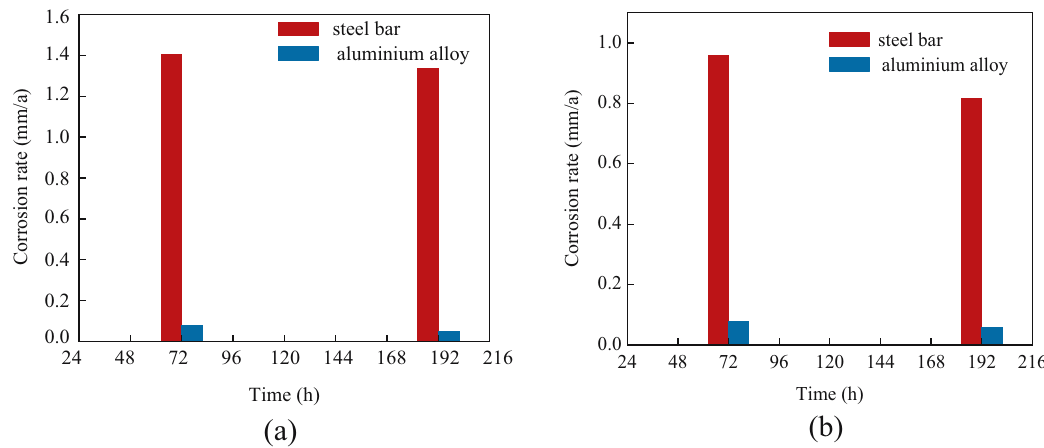
Figure 7: Comparison of corrosion rate between aluminum alloy and steel bar: ( a ) simulated acid rain and ( b ) chloride solution.